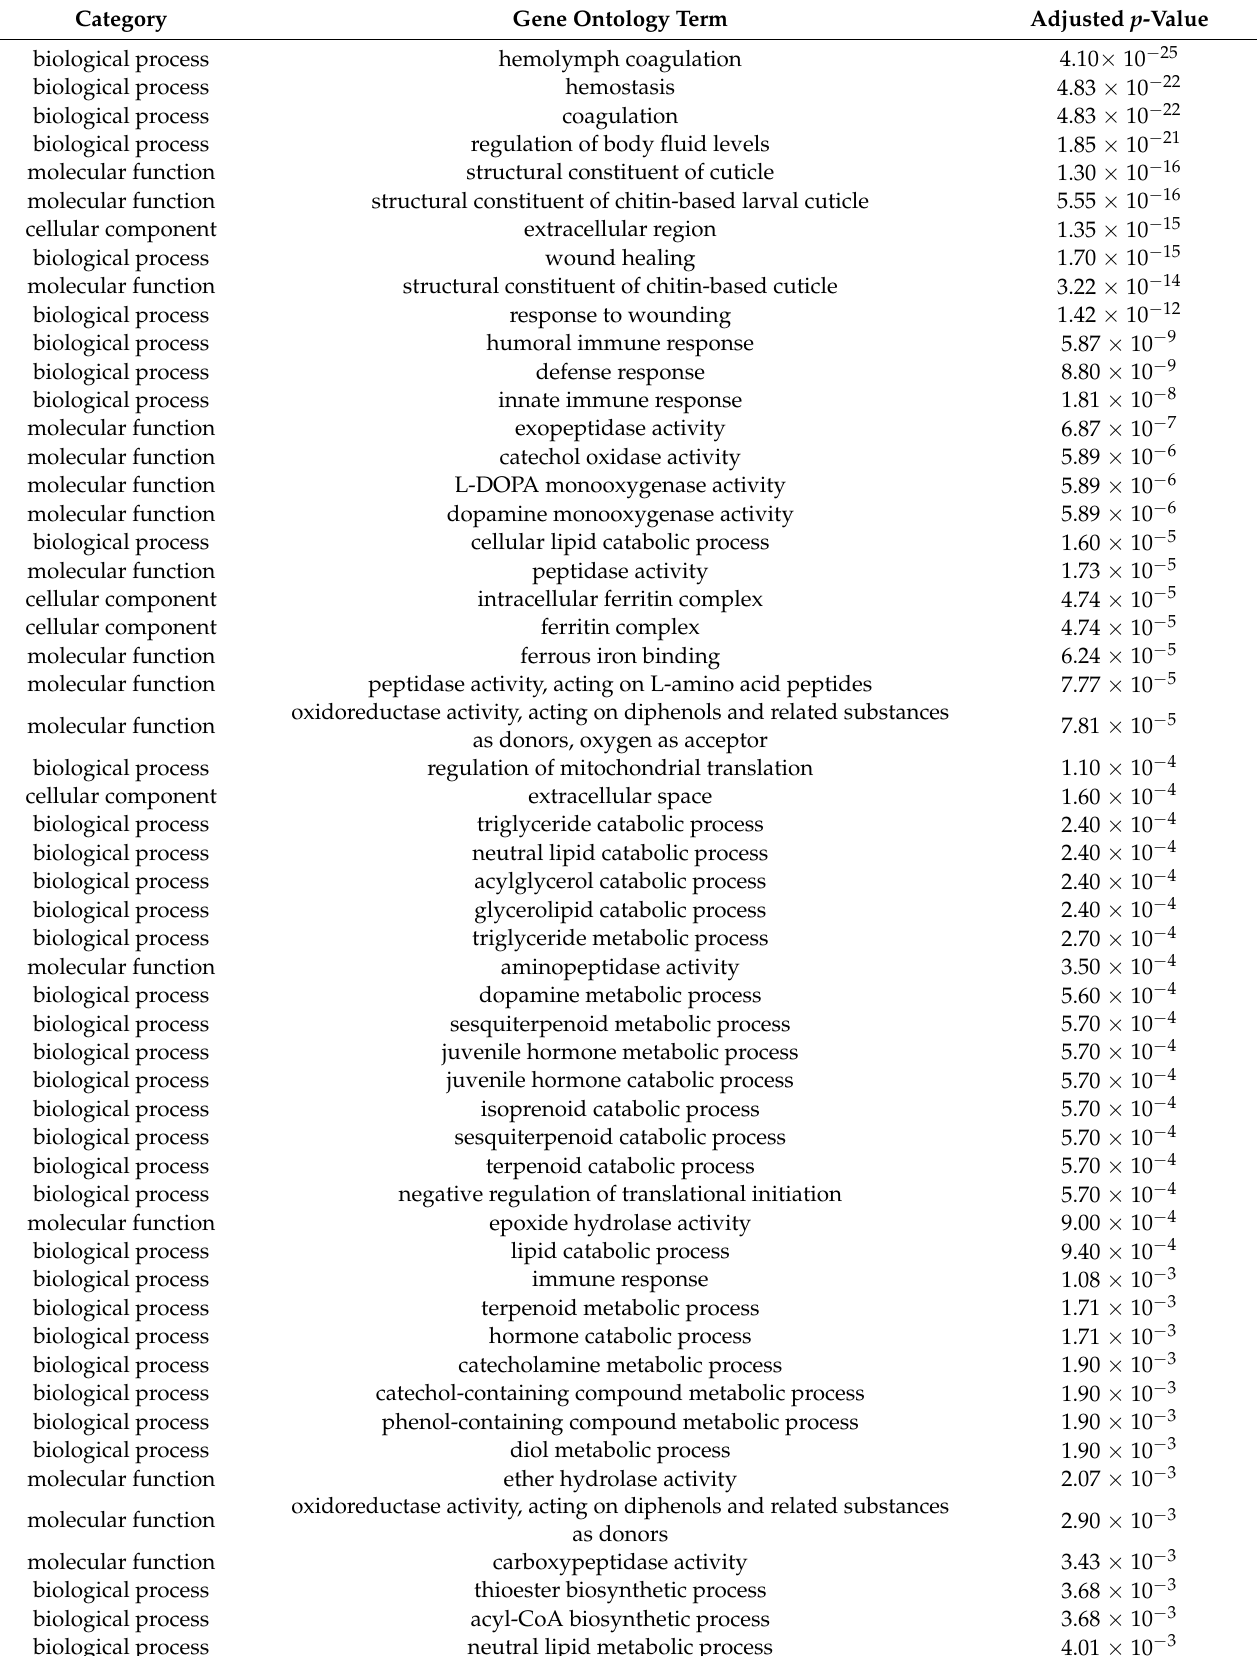
Table 2. Gene ontology term enrichment analyses results for the differentially expressed